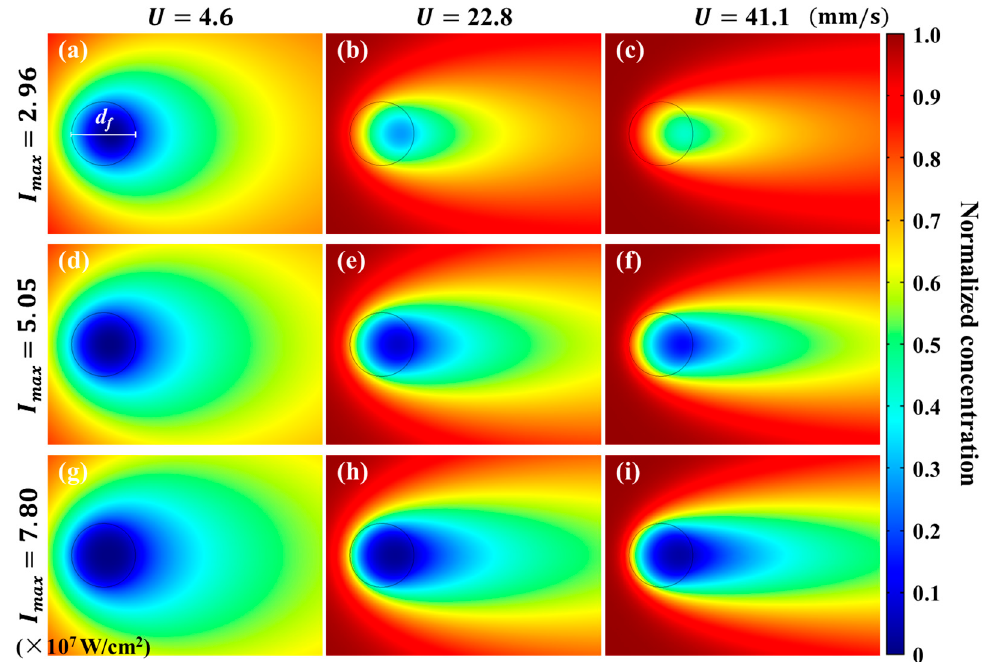
Figure 5. Distribution of effective concentration 𝐶 of fluorescent dye under different bulk flow velocities and laser power densities. ( a – c ) 𝐶 under 𝐼 (cid:2923)(cid:2911)(cid:2934) (cid:3404) 2.96 (cid:3400) 10 (cid:2875) W/cm 2 , with 𝑈 (cid:3404) 4.6, 22.8, 41.1 mm/s, respectively. ( d – f ) 𝐶 under 𝐼 (cid:2923)(cid:2911)(cid:2934) (cid:3404) 5.05 (cid:3400) 10 (cid:2875) W/cm 2 , with 𝑈 (cid:3404) 4.6, 22.8, 41.1 mm/s, respectively. ( g – i ) 𝐶 under 𝐼 (cid:2923)(cid:2911)(cid:2934) (cid:3404) 7.80 (cid:3400) 10 (cid:2875) W/cm 2 , with 𝑈 (cid:3404) 4.6, 22.8, 41.1 mm/s, respectively. Here, the concentration values have been normalized by the maximum 𝐶 . The black circle represents the integration region of fluorescence to calculate 𝐼 (cid:3033)